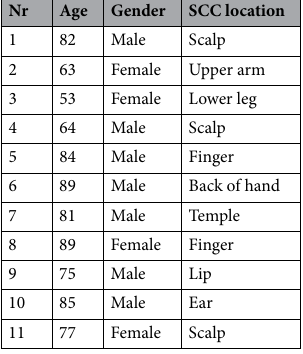
Table 2. Patient